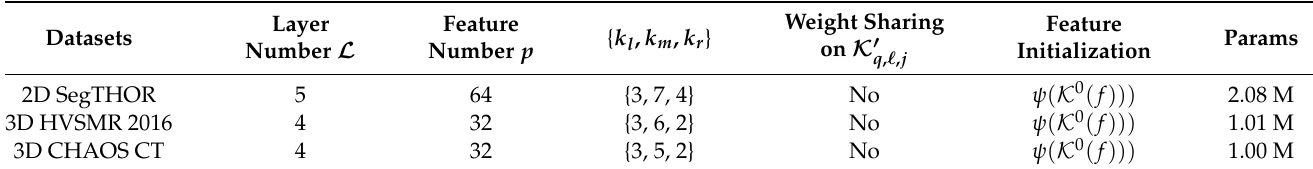
Table 6. The hyperparameter configurations of the proposed FAS-UNet framework on differ- ent datasets.